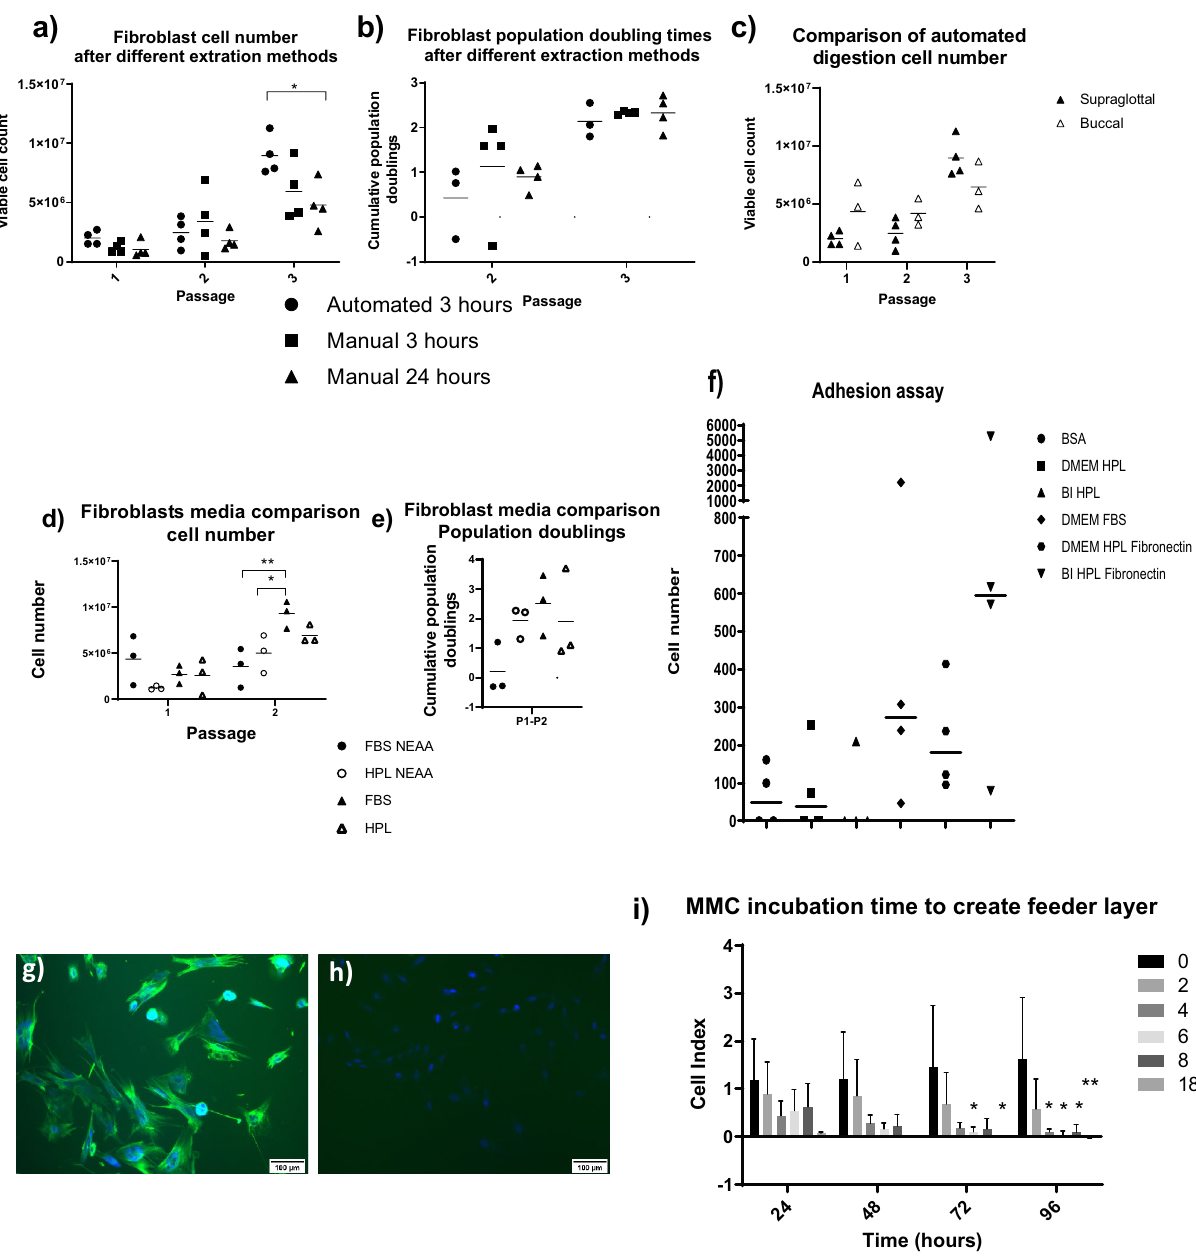
Figure 1. Fibroblasts. Supraglottal fibroblasts were extracted using 3 different methods, the viable cell number ( a ) and the population doublings ( b ) were recorded up to passage 3. Data are mean plus data points n = 4. *P ≤ 0.05 (Two way ANOVA with Tukey’s multiple comparisons). Buccal tissue was extracted via automated method and compared to supraglottal tissue ( c ), there was no significant difference between tissue type. Following extraction buccal fibroblasts were grown in 4 compositions of media, DMEM containing either FBS NEAA, HPL NEAA, FBS or HPL, cell number ( d ) and population doubling ( e ) were recorded up to passage 2. FBS medium had a significantly higher cell number than both NEAA containing medium by passage 2. Data are mean plus data points, n = 3 *P < 0.05 **P < 0.01 (two way ANOVA with Tukey’s multiple comparison). Adhesion of buccal fibroblasts was examined ( f ). Cells were fluorescently labelled with Calcein AM and added to a 96 well plate with BSA coating as a negative control, fibroblast medium containing HPL and FBS compared to Bi HPL medium, and fibronectin coating with both HPL containing media for 3 h. After washing, the plate was read. Data are median plus data points n = 4. Fibrolast were stained with fibroblast marker vimentin ( g ) and myofibroblast marker αSMA ( h ) n = 3, scale bar shows 100 μm. MMC incubation time for the creation of feeder layers ( i ) Cells were treated with MMC for 0, 2, 4, 6, 8 and 18 h before being placed into the xCELLigence plate reader. Readings were taken every hour for 96 h. Data are mean ± SD, n = 3. *P < 0.05 **P < 0.01, for comparison to untreated control (two way ANOVA and Tukey’s multiple